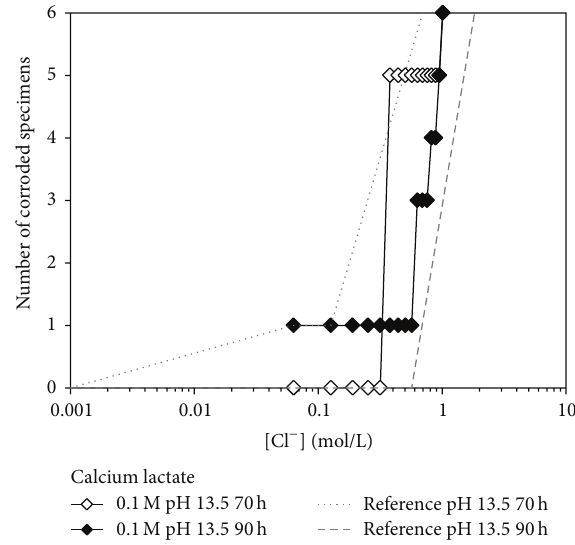
Figure 6: Number of corroded specimens as a function of chloride addition during potentiostatic test in solutions with calcium